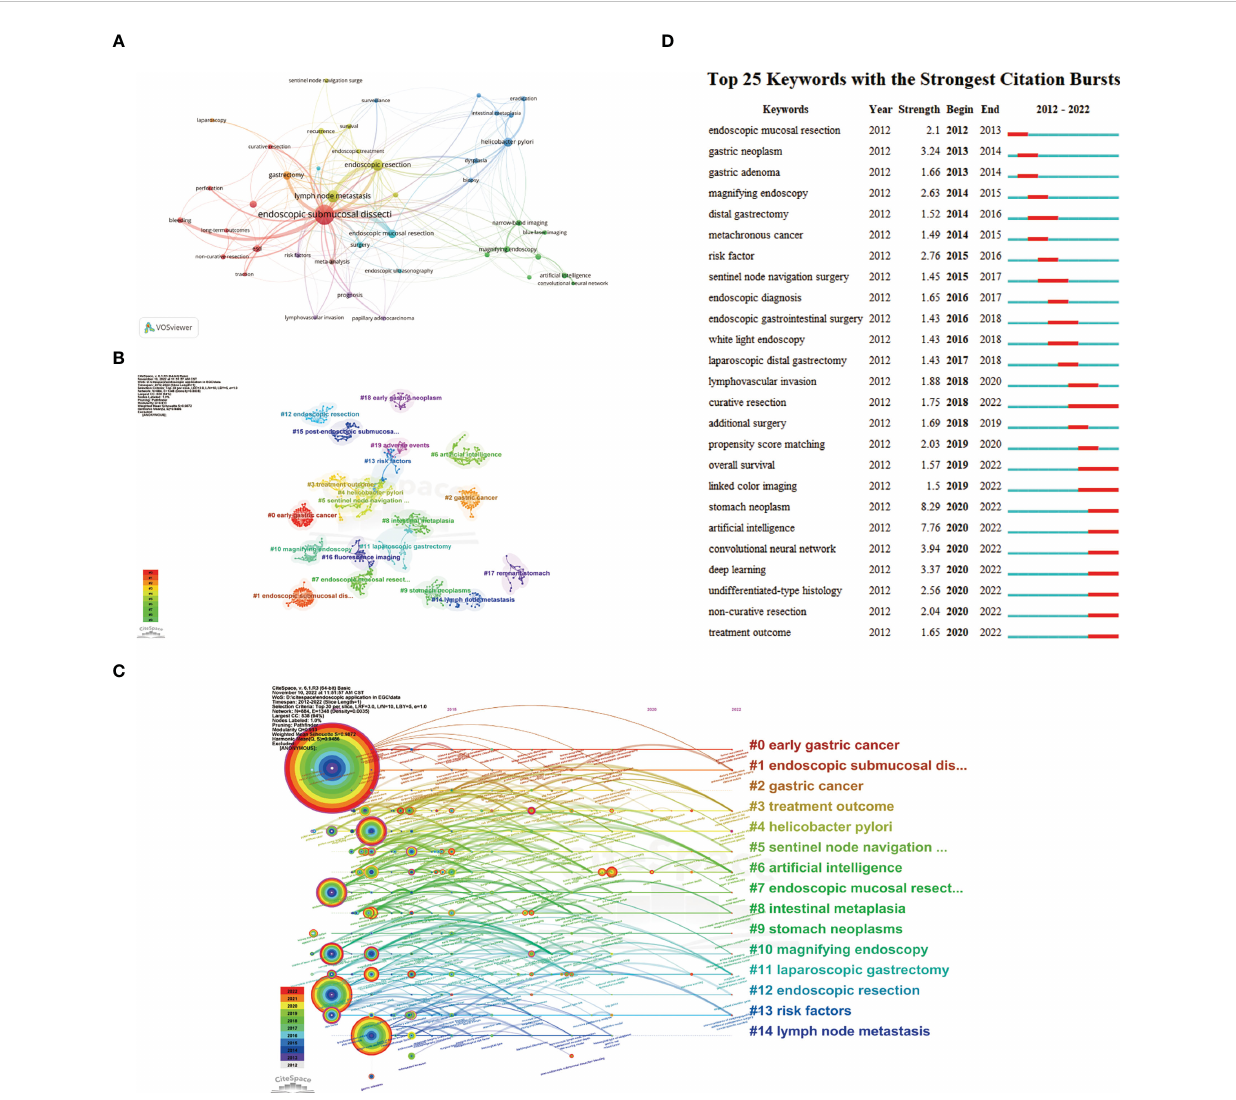
FIGURE 8 (A) . Network visualization map of the keywords occur more than 10 times, divided into 8 clusters with individual color. (B) A landscape view of keyword cluster analysis indicates the top 20 clusters. The different clusters are represented by different colors and shapes. (C) Timeline view visualization map of keywords, only images the top 15 clusters. The time evolution is indicated with different colored lines, and the nodes on the lines indicate the occurrence of the keyword. (D) Top 25 keywords with the strongest citation bursts from 2012 to